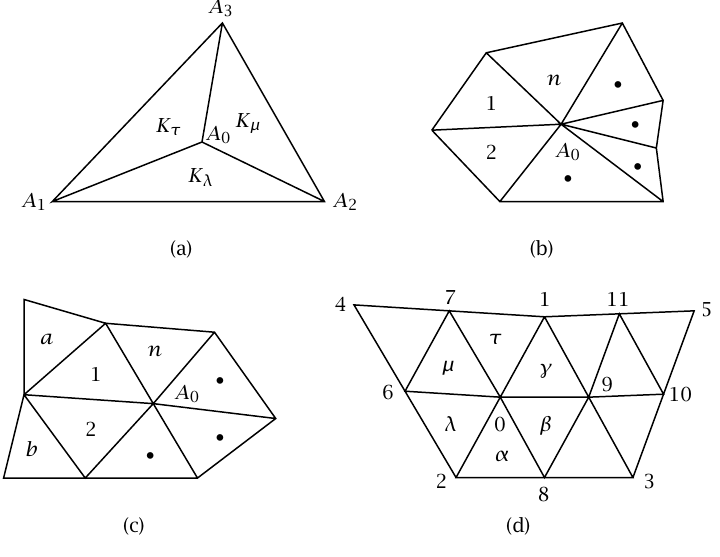
Figure 3.1 . Examples of